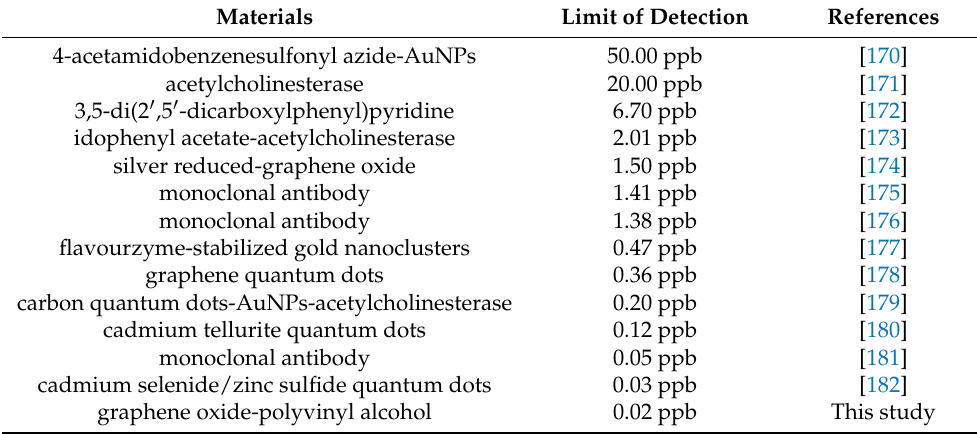
Table 1. Comparison of the lowest detection carbaryl with various material-based optical sensors.